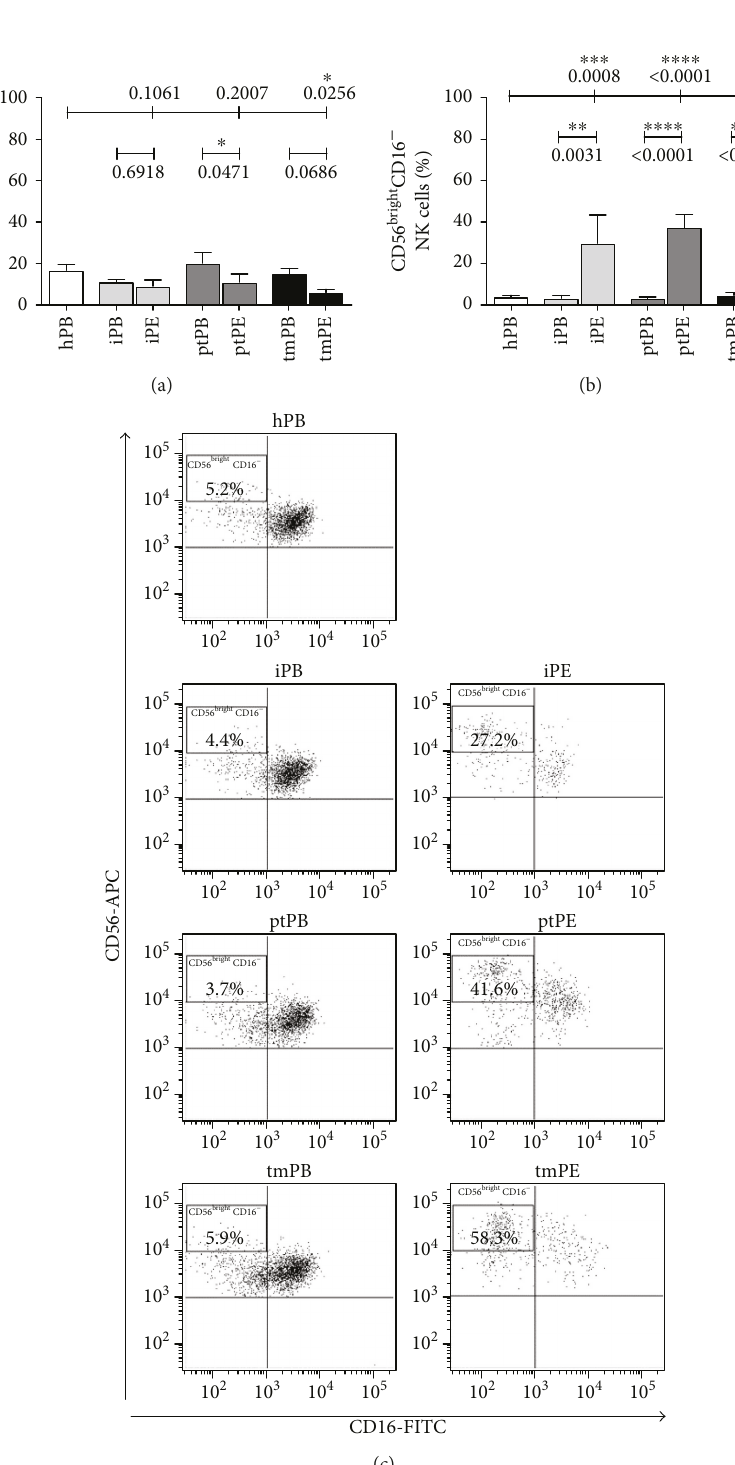
Figure 1: NK cell subset distribution in pleural e ff usion samples and controls. Flow cytometric analysis showed the percentage of NK cells in all samples from healthy controls (hPB), peripheral blood (iPB) and pleural e ff usion (iPE) from patients with in fl ammatory disease, peripheral blood (ptPB) and pleural e ff usion (ptPE) from patients with primary tumor, and peripheral blood (tmPB) and pleural e ff usion (tmPE) from patients with tumor metastasis. (a). CD56 bright CD16 − cell subset predominated in all the PE samples with a percentage ranging from 35% in iPE, to 40% in ptPE, and to 60% in tmPE. On the contrary, in PB of pleural e ff usion patients and healthy controls, the percentages of CD56 bright CD16 − NK cells were approximately 5% (b). Representative dot plots of healthy donors and patients with in fl ammatory, primary, and metastatic tumor PE are shown, respectively (c). Data are shown as mean ± SEM of 46 samples; ∗ p < 0 05 , ∗∗ p < 0 01 , ∗∗∗ p < 0 001 , and ∗∗∗∗ p < 0 0001 ( p values are